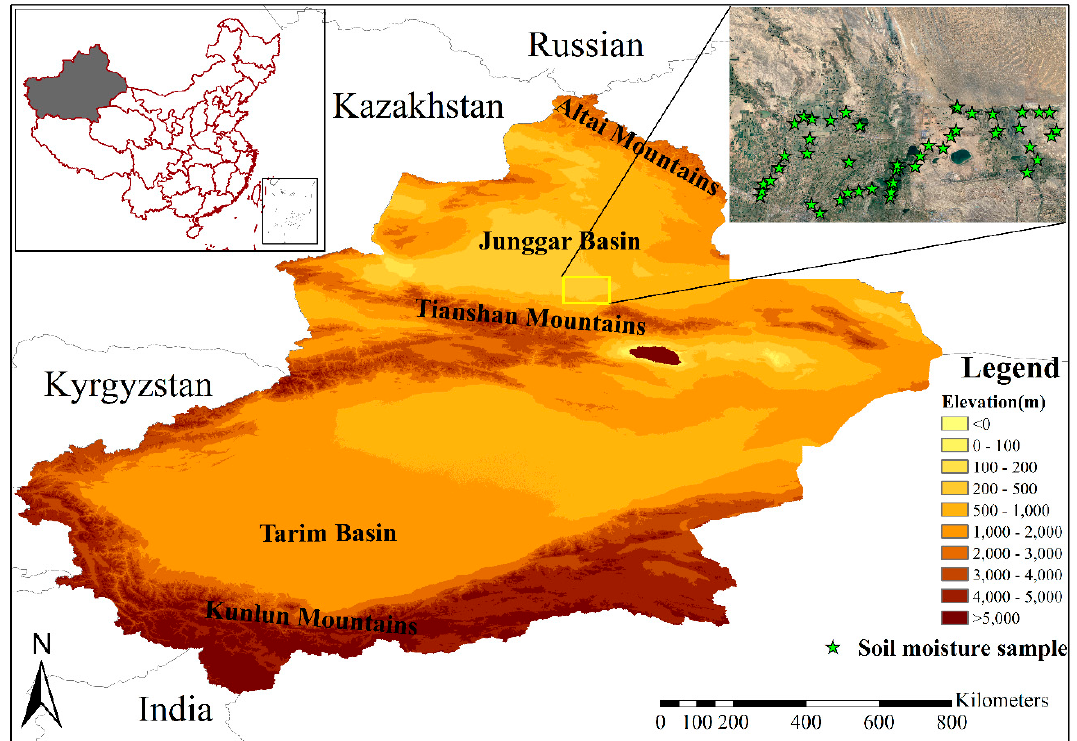
Figure 1. Study area (Xinjiang Uygur Autonomous Region, China). The inset image is the surrounding area of the Fukang City and locations of fifty-one soil samples were taken.